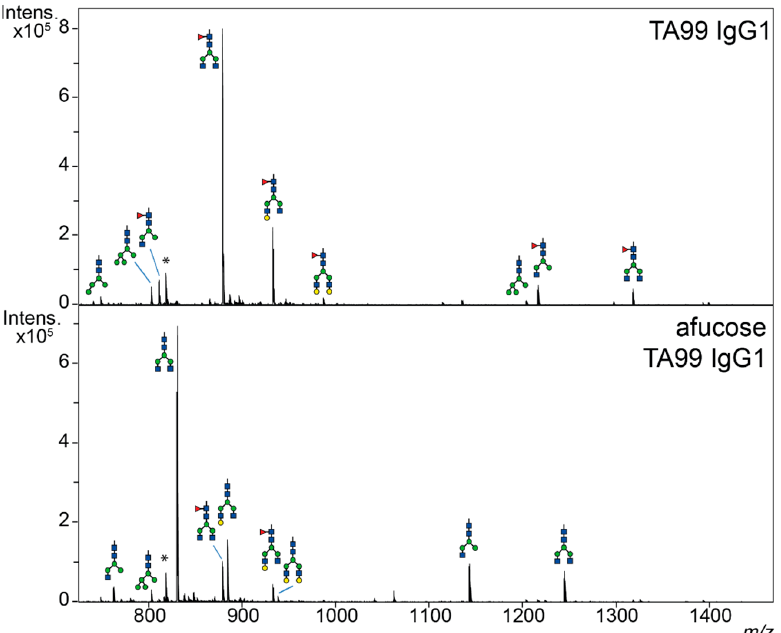
Figure 1. Afucosylated antibodies have minimal expression of fucose on glycans. LC-MS spectra of trypsin-generated human IgG1 glycopeptides. Glycopeptide species were observed in both triple-charged form (below m / z 1000) and double charged form (above m / z 1000). Top humanized fucosylated hIgG1-TA99 and bottom, afucosylated hIgG1-TA99. Green circle = mannose; yellow circle = galactose; blue square = N -acetylglucosamine; red triangle = fucose; * = unidentified